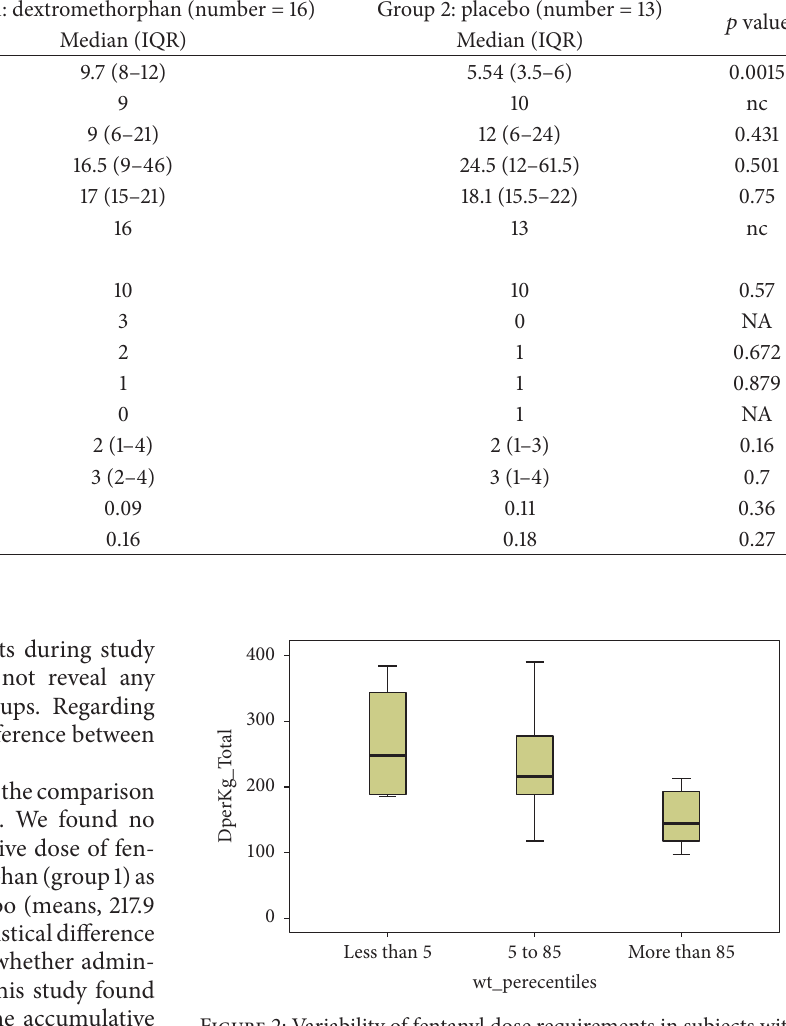
Figure 2: Variability of fentanyl dose requirements in subjects with different weight percentiles in dextromethorphan